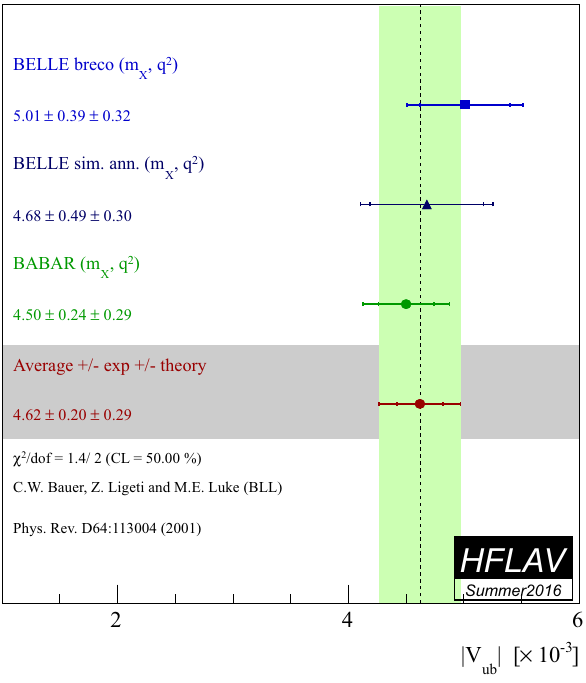
Fig. 65 Measurements of | V ub | from inclusive semileptonic decays and their average in the BLL prescription